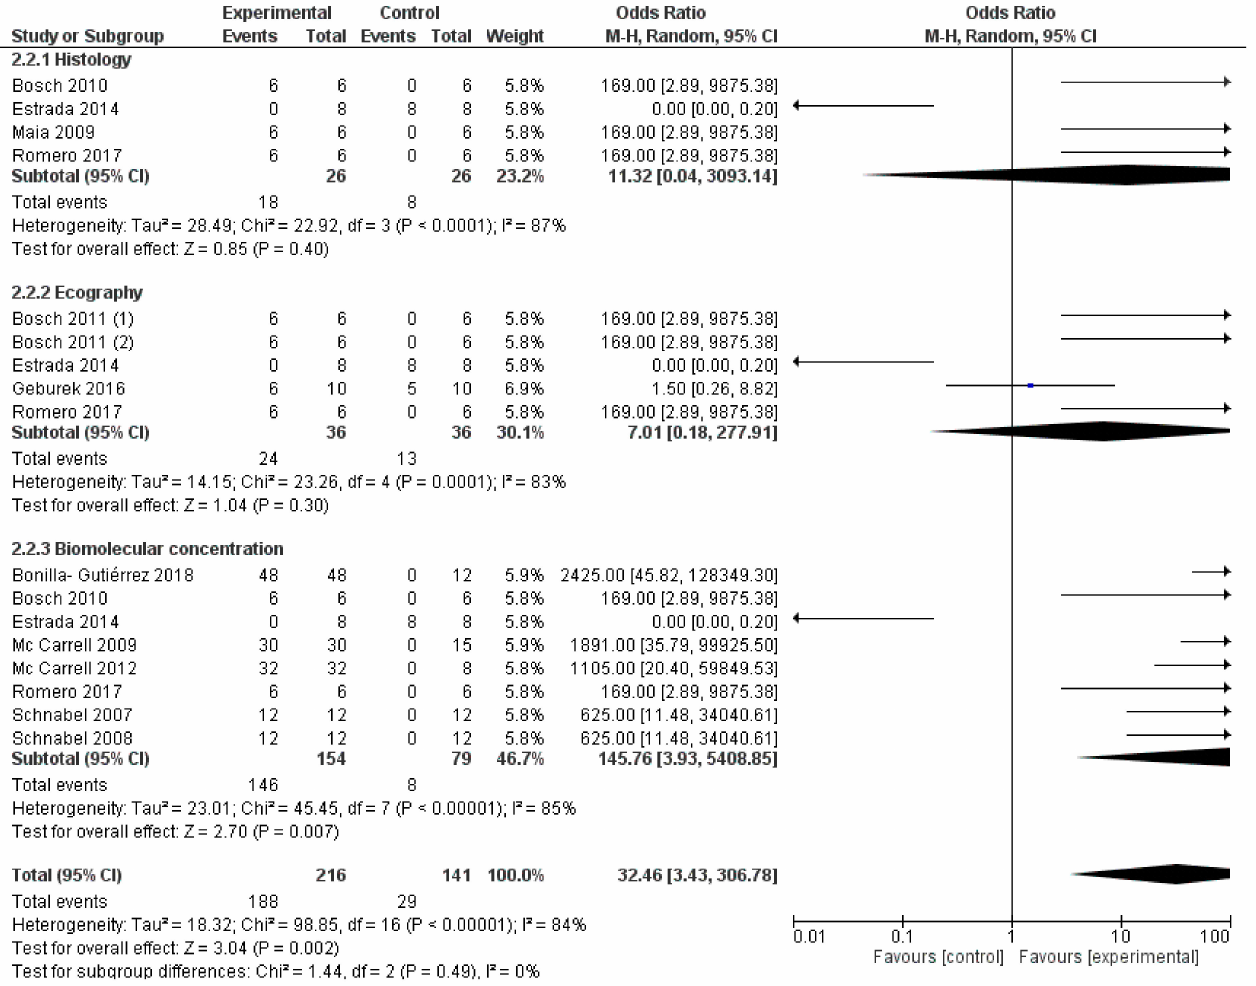
Figure 3. Forest plot representing successful outcomes of selected studies, divided into different subgroups, using a meta-analytic approach based on the random-effects model. The squares represent the positive outcome of individual studies, with the whiskers corresponding to the 95% confidence interval (95% CI). The diamonds correspond to the study’s positive outcome and 95% CI of every subgroup and